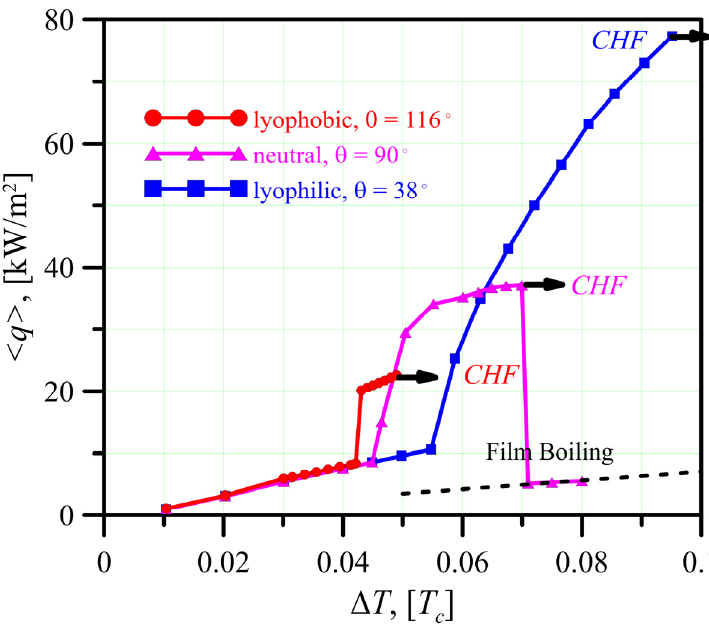
Figure 2. Boiling curves q ( Δ T ′ ) for the smooth surfaces with homogeneous wettability: lyophilic surface ( θ = 38°), neutral surface ( θ = 90°), lyophobic surface ( θ = 116°).